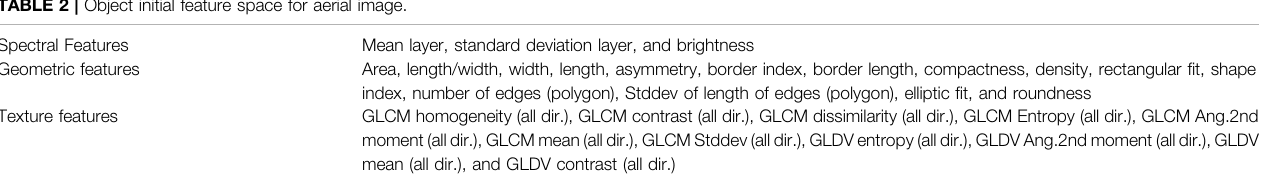
TABLE 2 | Object initial feature space for aerial